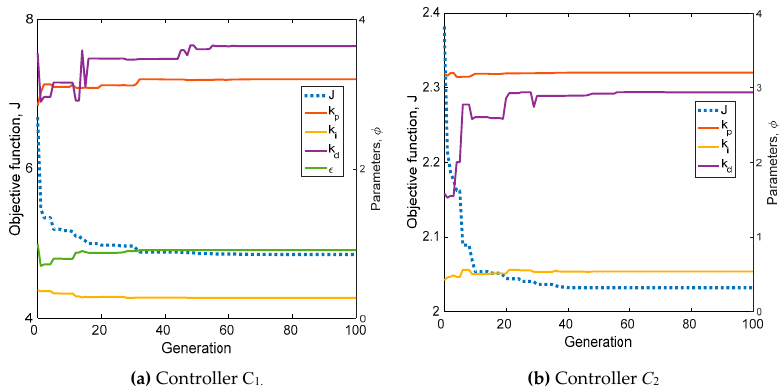
Figure 6. GA based evolutionary tuning of controllers C 1 and C 2 for process 1.